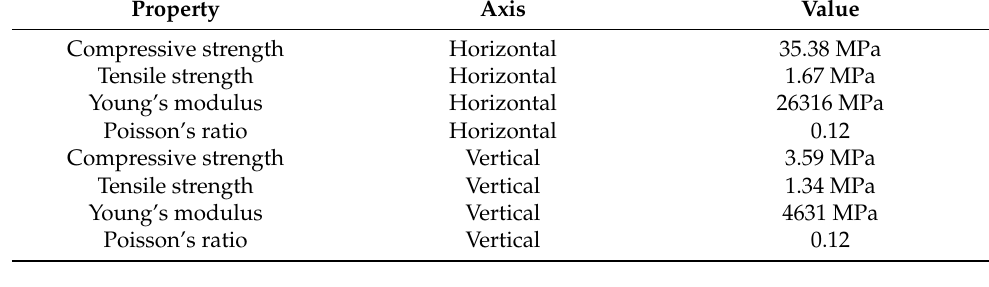
Figure 32. Stress ( left ) and strain ( right ) distribution of sustainable red mud bricks using ANSYS.